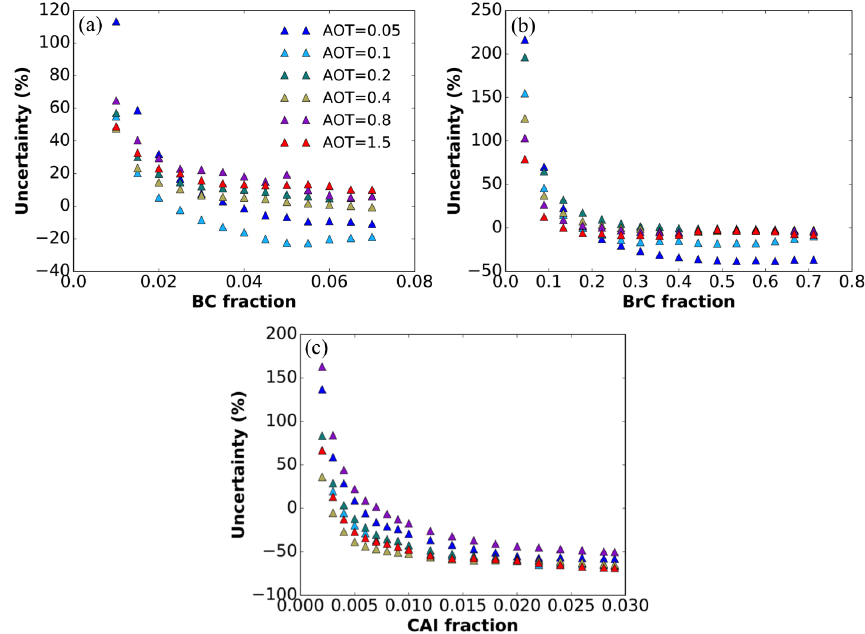
Figure 6. Uncertainty in absorbing species retrievals from POLDER/PARASOL attributed to the refractive index variability; uncertainties in the (a) BC, (b) BrC, and (c) CAI